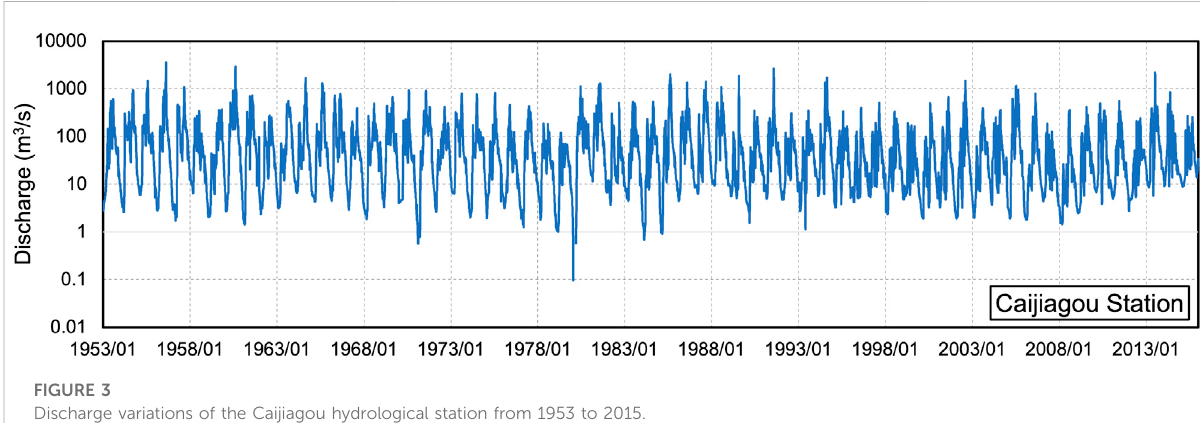
FIGURE 3 Discharge variations of the Caijiagou hydrological station from 1953 to